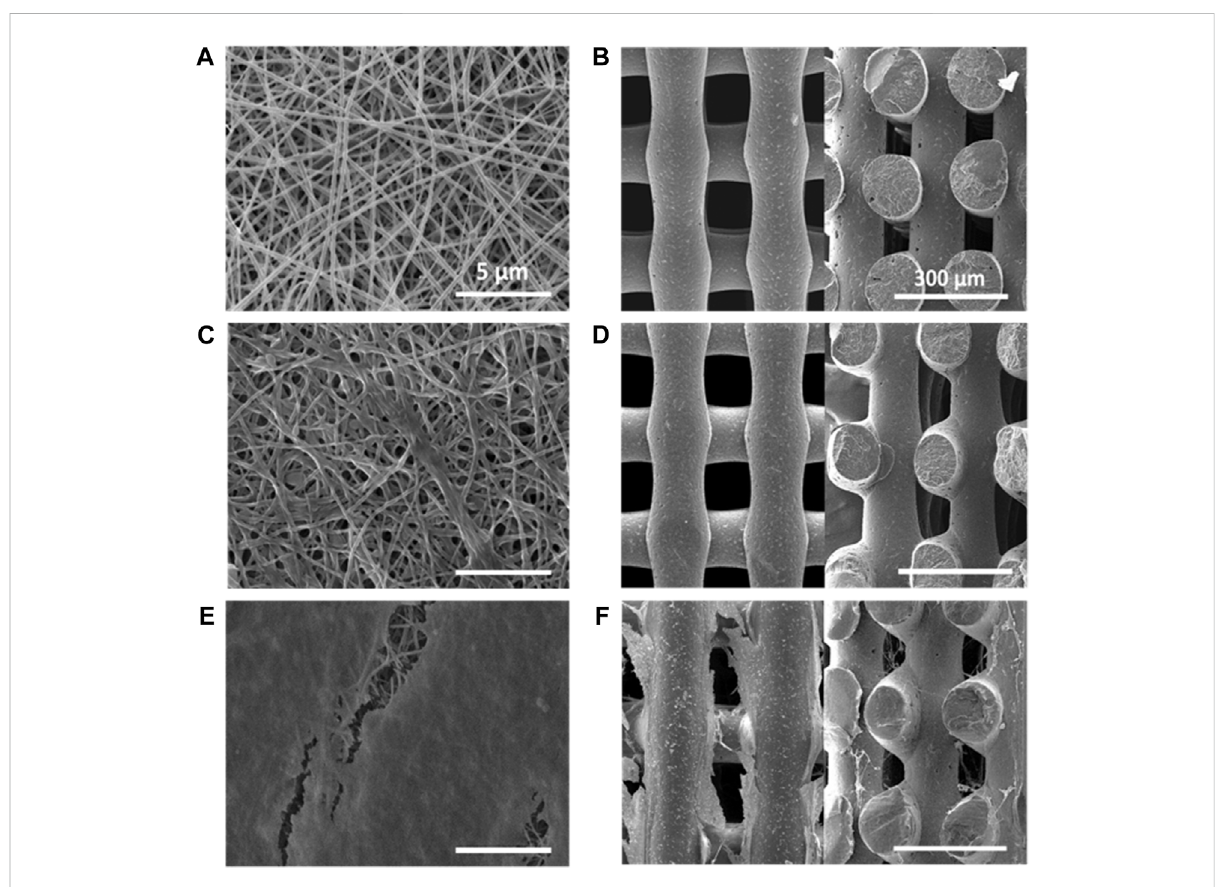
FIGURE 1 SEMimagesofPCLscaffolds: (A) 2Dscaffold(topview); (B) 3Dscaffold(leftimage:topviewinx-yplane;rightimage:sectioninx-zplane);PCL/ PolyDOPA/G scaffolds: (C) 2D scaffold (top view); (D) 3D scaffold (left image: top view in x-y plane; right image: section in x-z plane; decellularized PCL/PolyDOPA/G scaffolds after 21 days v-HCFs culture: (E) 2D scaffold (top view); (F) 3D (left image: top view in x-y plane; right image: section in x-zplane).Section imageswereacquired on 3Dscaffold samples fractured in liquid nitrogen. Scalebars:5 µmfor 2D scaffolds (A,C,E) ;300 µm for 3D scaffolds (B,D,F)